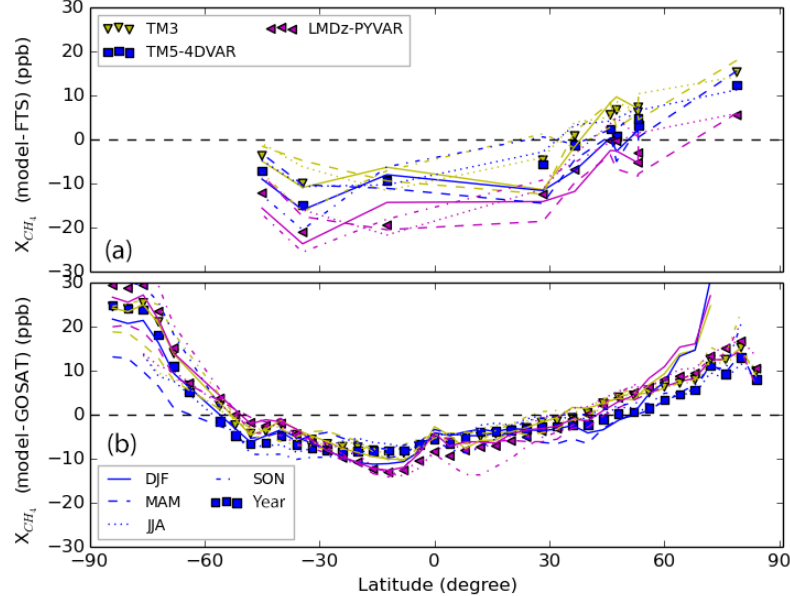
Figure 2. Yearly and seasonal mean model bias of total column-averaged CH 4 mole fractions plotted as a function of latitude. Panel (a) is the results using FTS data while panel (b) is for GOSAT. The difference for the models is given in yellow (TM3), blue (TM5-4DVAR), and magenta (LMDz-PYVAR). The average of FTS results is for the period 2007–2011 where FTS measurements are available, and for GOSAT in the period